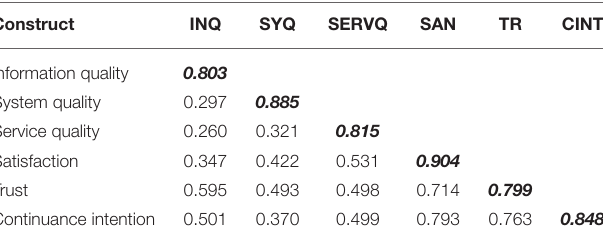
TABLE 2 | Convergent validity.